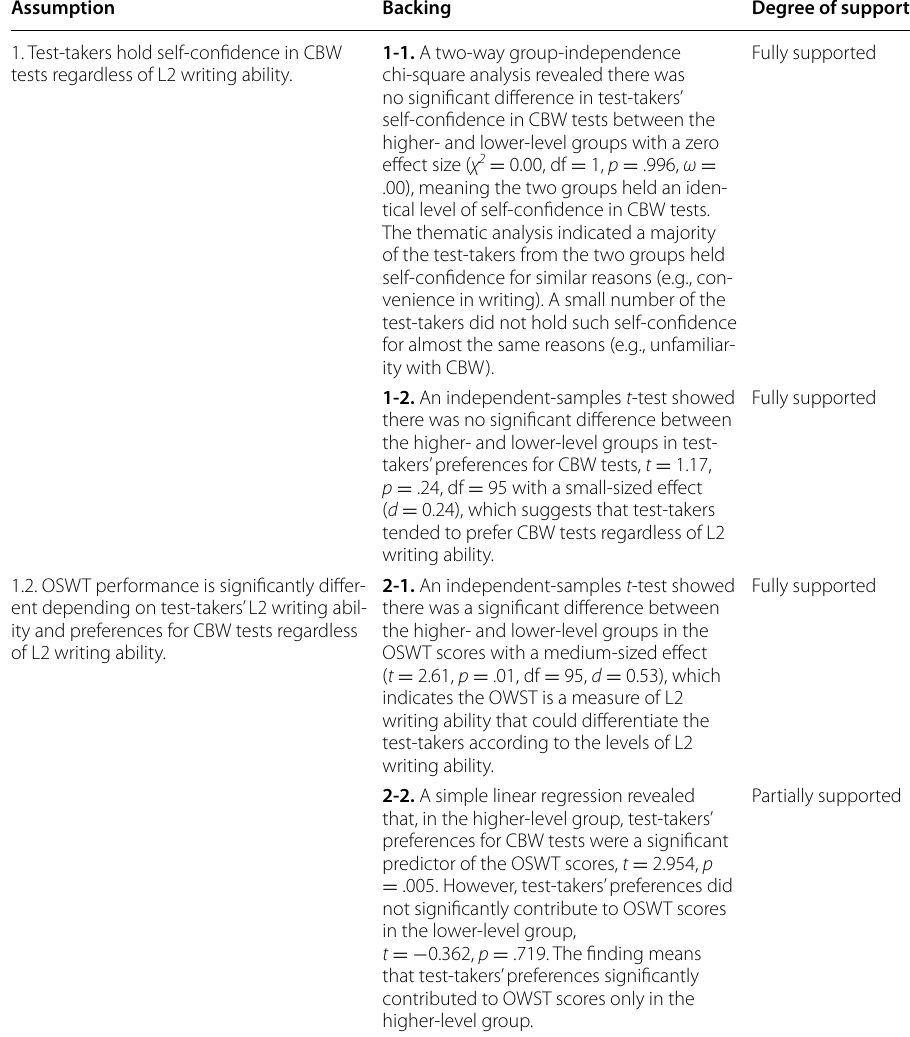
Table 7 A summary of the partial validity argument for the OSWT with the assumptions, backing, and the judgment of the degree of